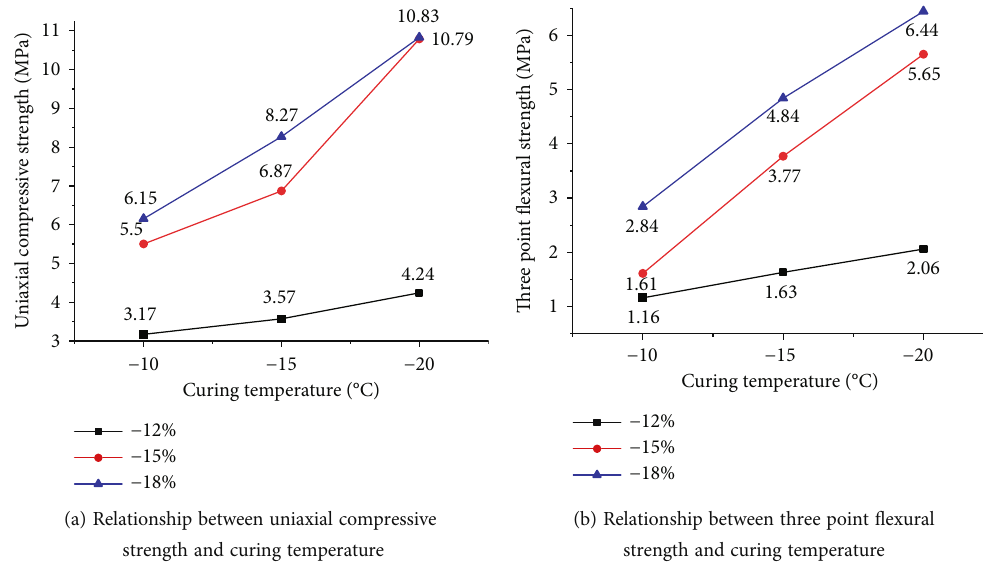
Figure 4: E ff ect of the water content on mechanical properties of arti fi cially frozen sandy soil. Table 3: Percentage of the increase in mechanical properties of arti fi cial frozen sand at di ff erent curing temperatures.